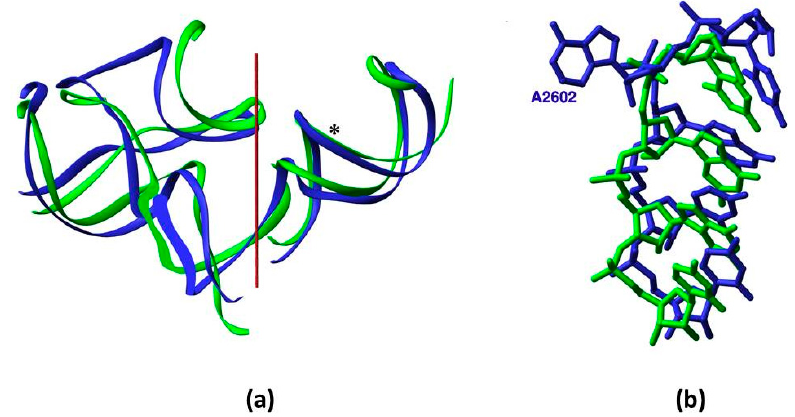
Figure 2. Symmetry: ( a ) Overlap of the backbone fold of the A- and the P-sub-regions, obtained by rotating the A-sub-region by 179.6° around the symmetry axis (in red); ( b ) The compatibility between the nucleotide conformation in the overlapped segments of the symmetry-related H89 and H93, whose backbone is marked by an asterisk in ( a ). Nucleotide A2602, which was suggested to be actively involved in translocation, diverges from the symmetry and bulges into the essentially symmetric PTC [7,8].